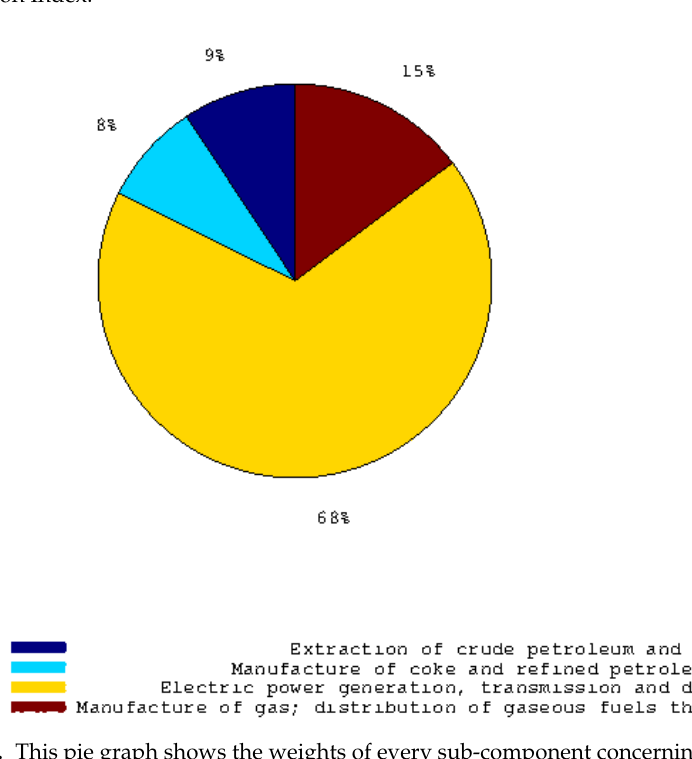
Figure 3. This pie graph shows the weights of every sub-component concerning the Italian Industrial Production Index of Electricity, gas, steam and air conditioning